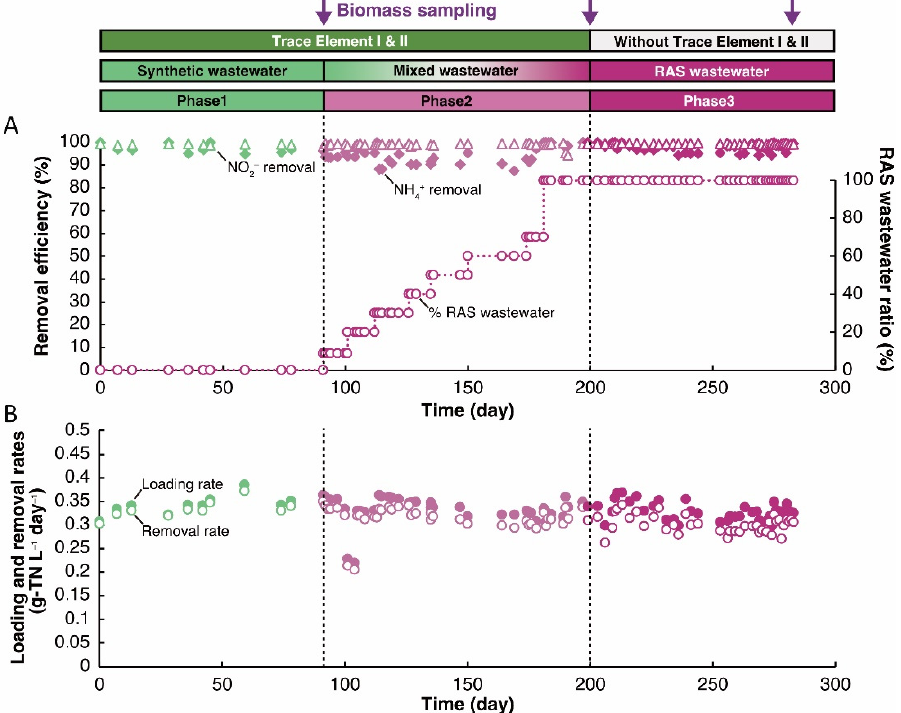
Figure 4. Anammox performance in the reactor. ( A ) NH 4+ (closed diamonds) and NO 2 − (open triangles) removal efficiencies. ( B ) Nitrogen loading and removal rates (filled and open circles, respectively). Dotted lines and open circle indicate changes in operational phase (artificial seawater or RAS WW, the presence of TE). RAS, recirculating aquaculture system WW; TE, trace element solutions. Purple arrows indicate biomass sampling on days 83, 200, and 280.